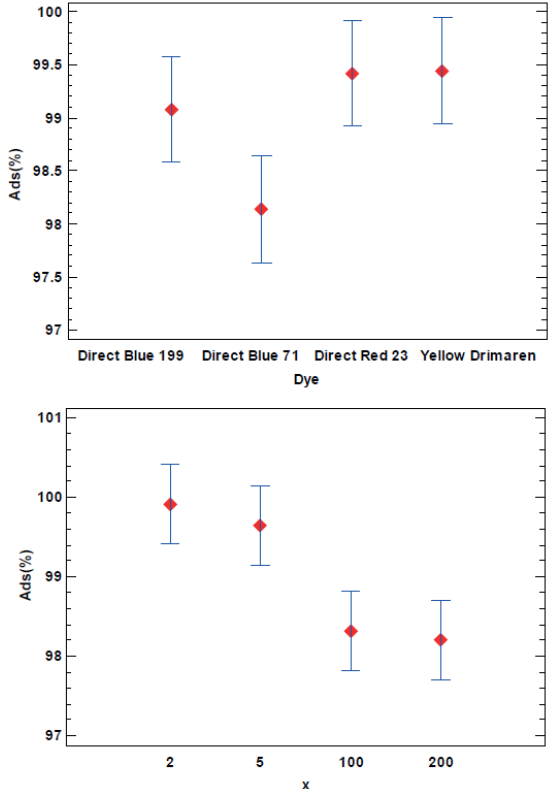
with the samples with Direct Red 23 is wider in the samples with Direct Blue 71. Figure 1. LSD Fisher means plot (95% confidence intervals) from Ads(%) as the response variable.